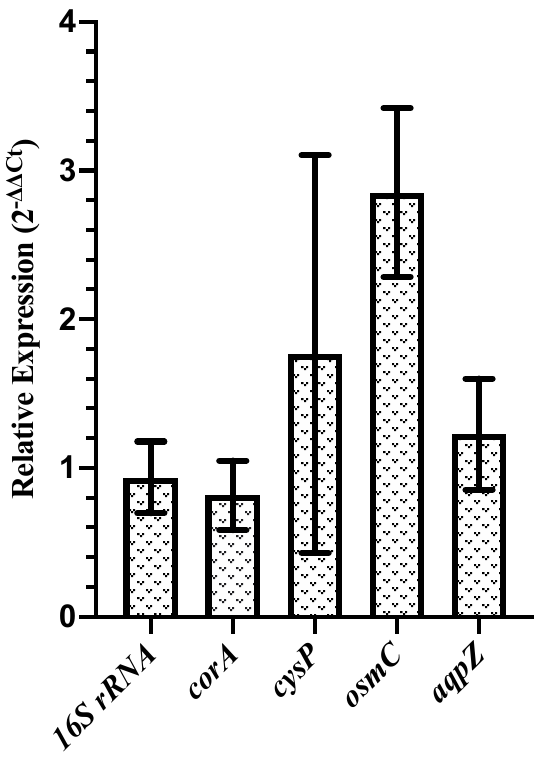
Figure 6. Relative expression, 2 − ∆∆ Ct , of the cells grown at 1.25 M magnesium sulfate as compared to cells grown in control media (2 mM MgSO 4 ). Gene encoding the sulfate transporter, cysP , and an osmotically inducible gene, osmC , are upregulated at high concentration of magnesium sulfate. The expression of cysP exhibits large variability across biological